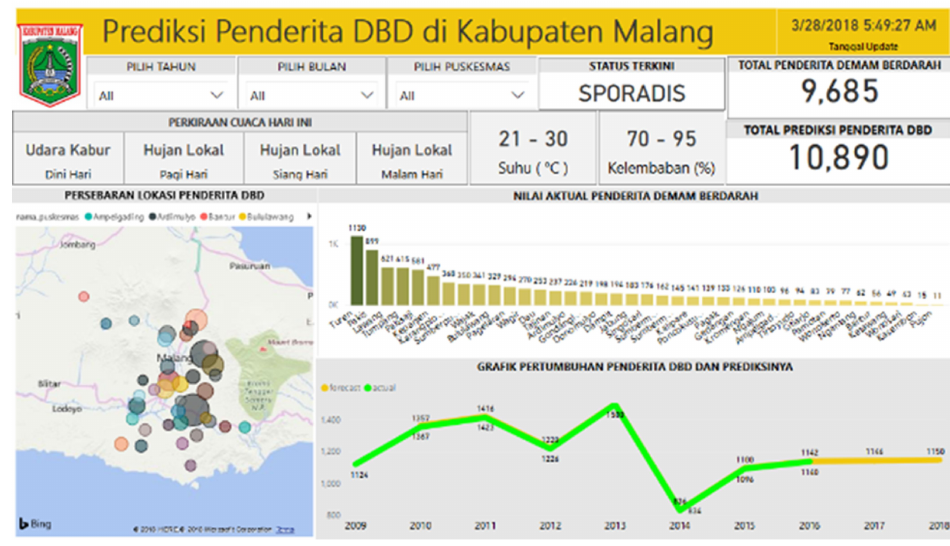
Fig. 5 Visualization of Dengue Hemorrhagic Fever Predicted Results - Main Dashboard.